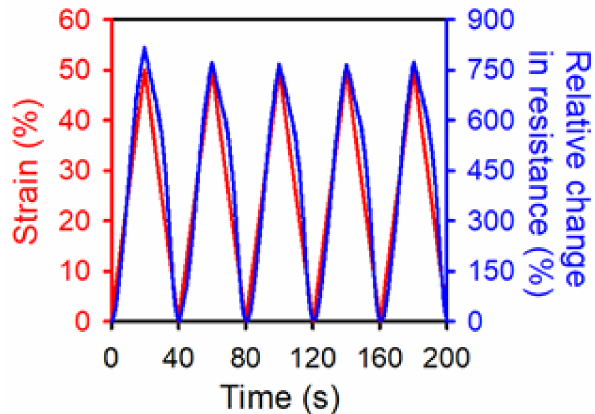
Figure 6. Relative change in resistance (blue) of the PDMS-shielded OPSS sensor during cycling at up to 50% strain